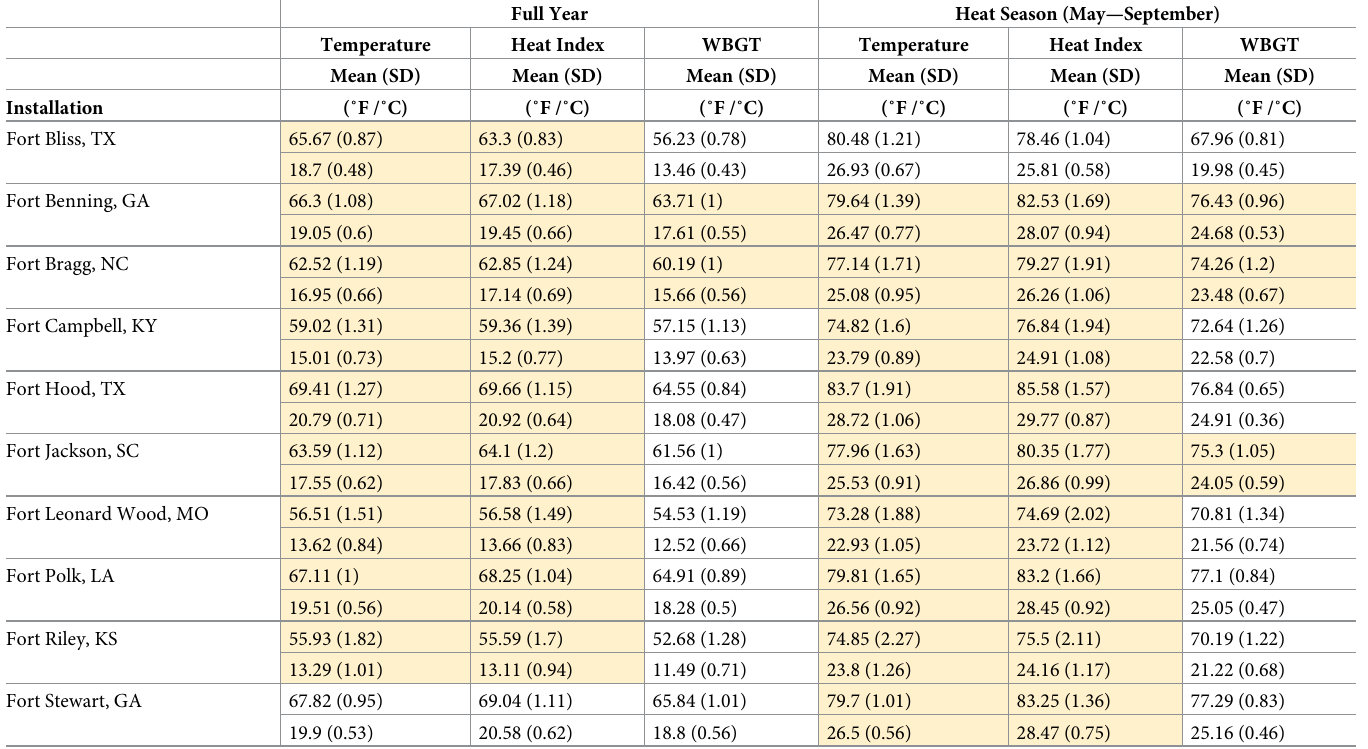
Table 3. Summary of absolute, mean degree-based annual indices of heat